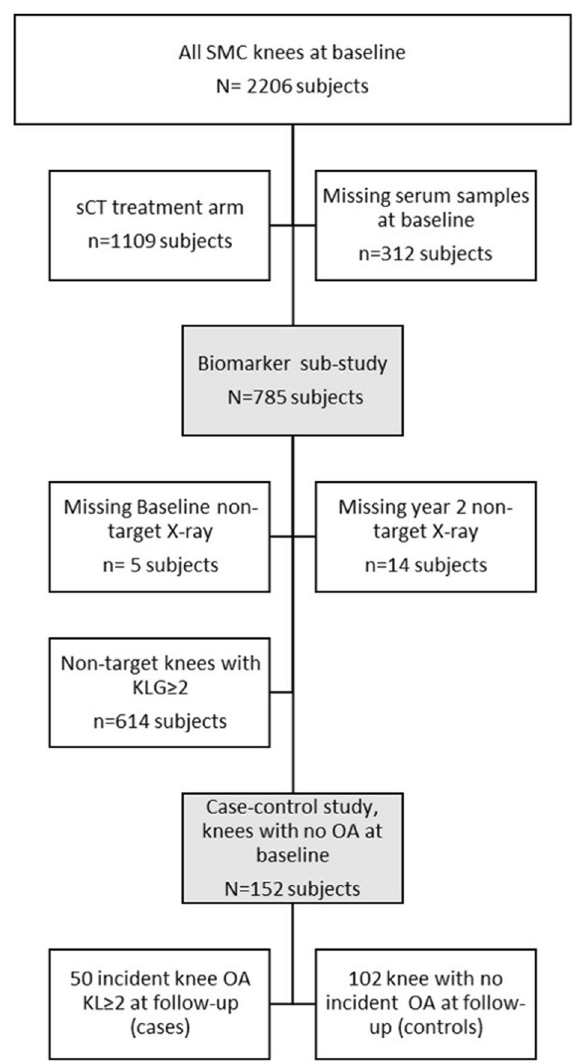
Figure 3. Overview for the osteoarthritis case–control study.